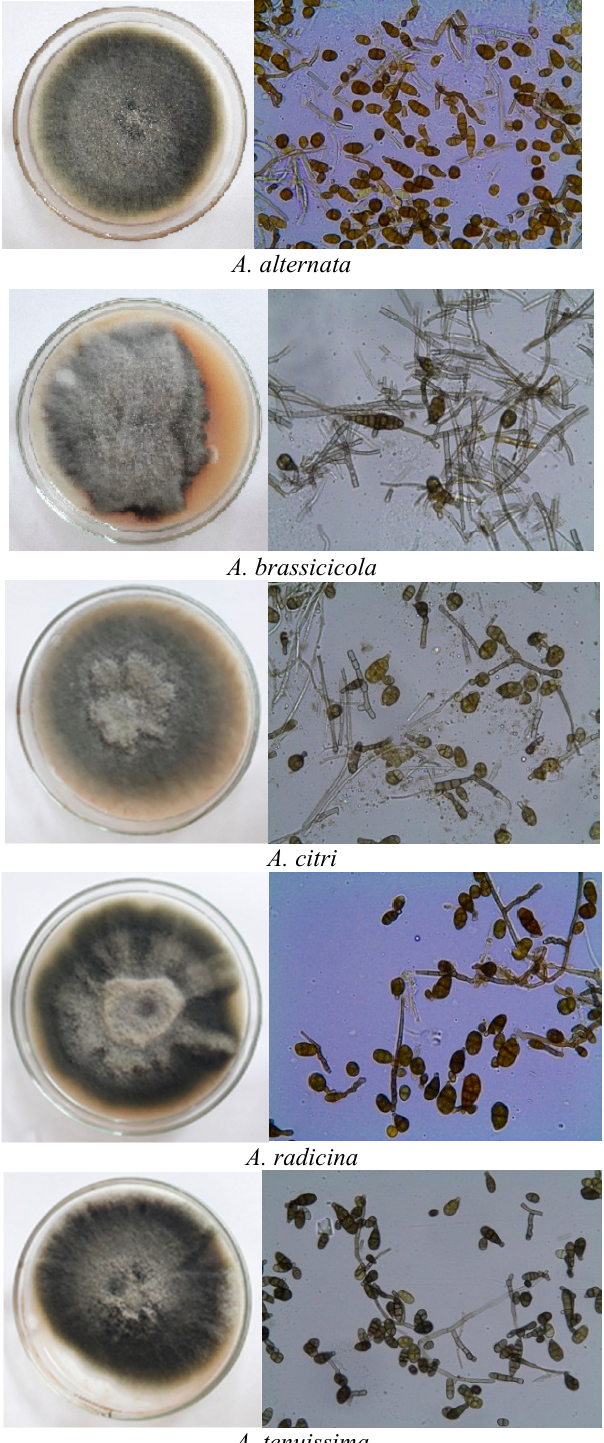
Figure 1. Alternaria species isolated from infected tomato fruits. Table 1. Measurement of different morphological structures of Alternaria species (averages of 10 conidia for each isolate).